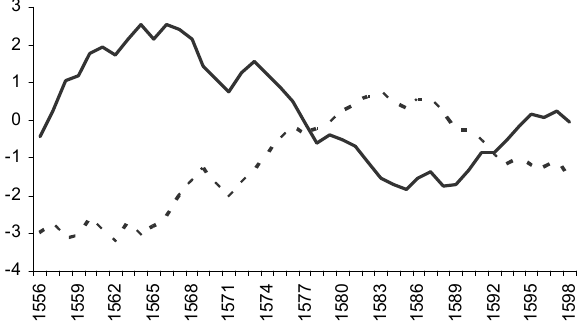
Fig. 6. Sequential Mann- Kendall curves of floods. Normal series Figure 6. Sequential Mann- Kendall curves of floods. Normal series (solid line) , (solid line), backward series (broken line). Tagus and Duero basins. backward series (broken line). Tagus and Duero basins. Y-axe =Man-Kendall index (u t ) Y-axis = Man-Kendall index (u t ) and (u t 0 ) ; X-axis = and (u t’ ) . X-axe= years.